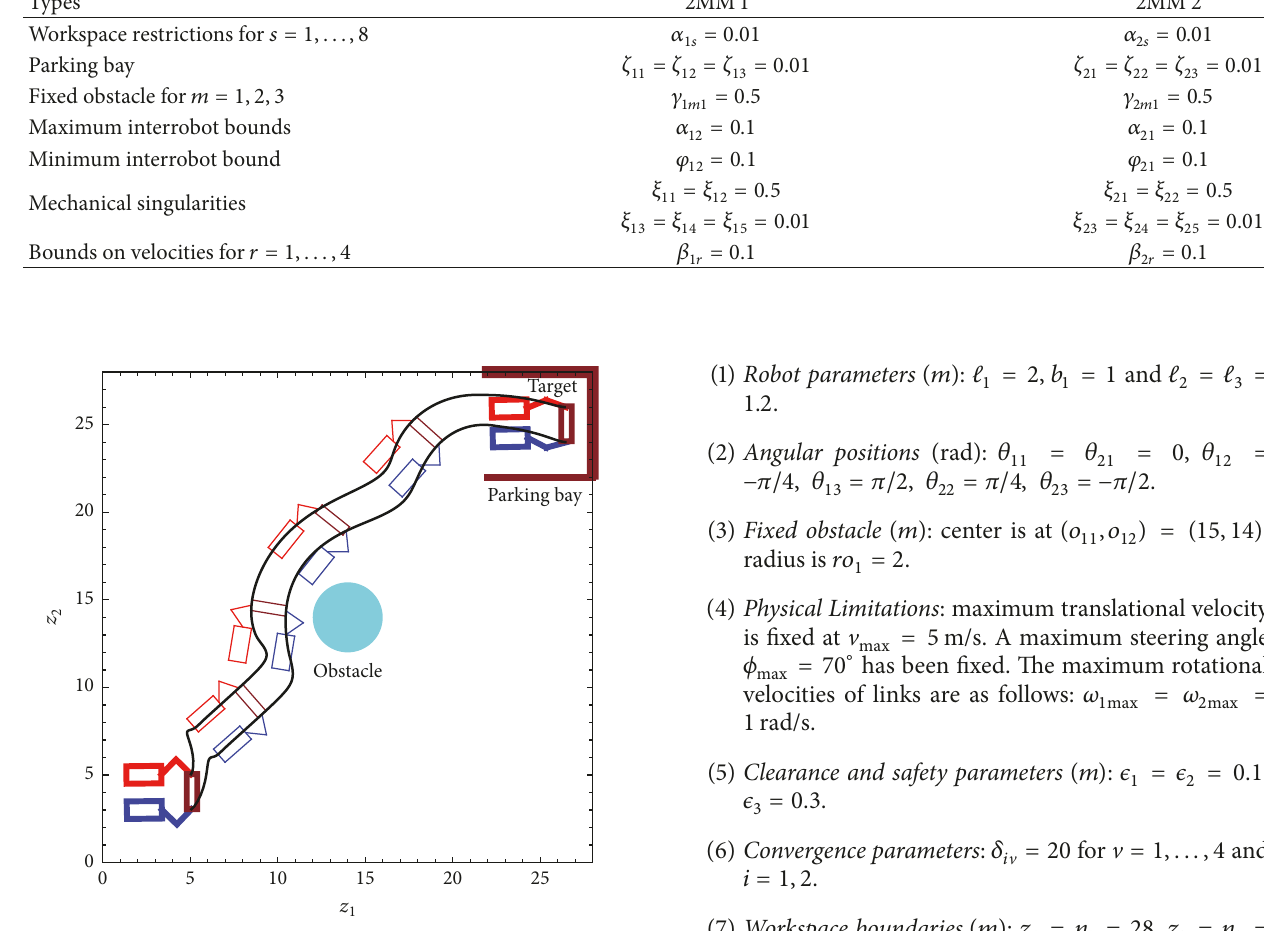
Figure 5: The resulting trajectories of 2MM teams transferring a rigid object. The positions of the lead and carrier robots are given as (𝑥 1 , 𝑦 1 ) = (5 m ,3 m ) and (𝑥 2 ,𝑦 2 ) = (5 m , 5 m ) , respectively. The translational velocities are given as 3 m/s while the rotational velocities are 𝜋/360 rad/s. The targets are fixed at (𝑝 11 ,𝑝 12 ) = (24 m ,26.5 m ) and (𝑝 , 𝑝 ) = (26 m ,26.5 m ) with a radii of 0.5 21 22